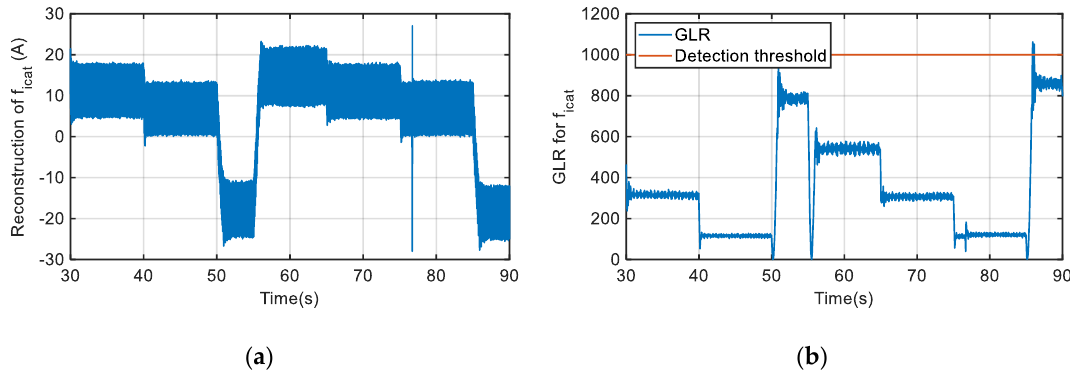
Figure12. Gainfaultinjectionincatenarycurrentsensor. ( a )Catenarycurrentsensorfaultreconstruction. Figure 12. Gain fault injection in catenary current sensor. ( a ) Catenary current sensor fault reconstruction. ( b ) ( b ) Generalized Likelihood Ratio (GLR) Generalized Likelihood Ratio (GLR) calculation.